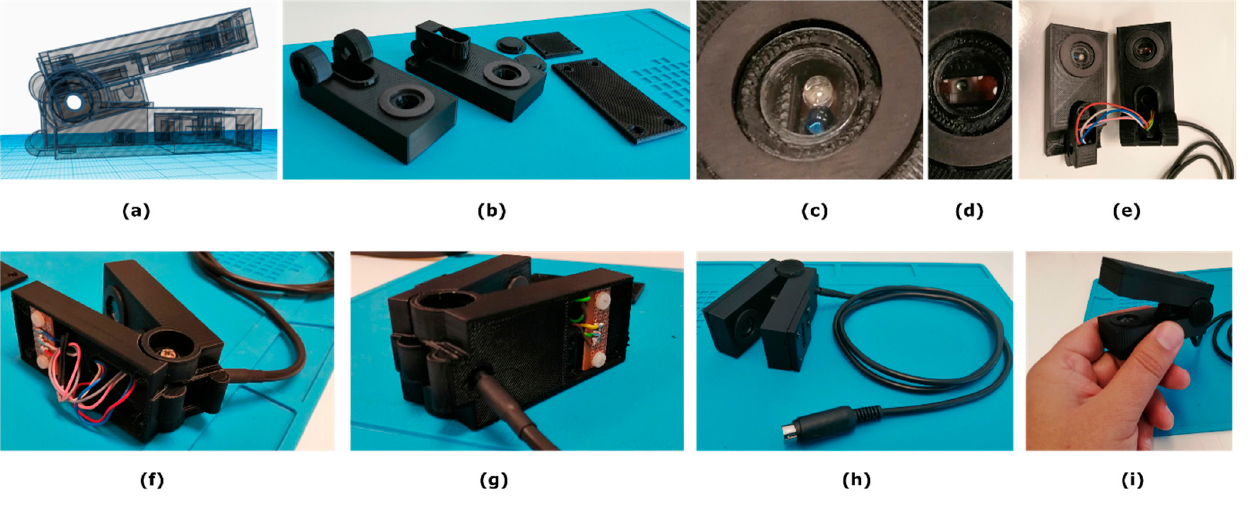
Figure 2. The experimental prototype sensor clip part of the device. Figures ( a – i ) show details from the concept design stage to the final implementation. the concept design stage to the final